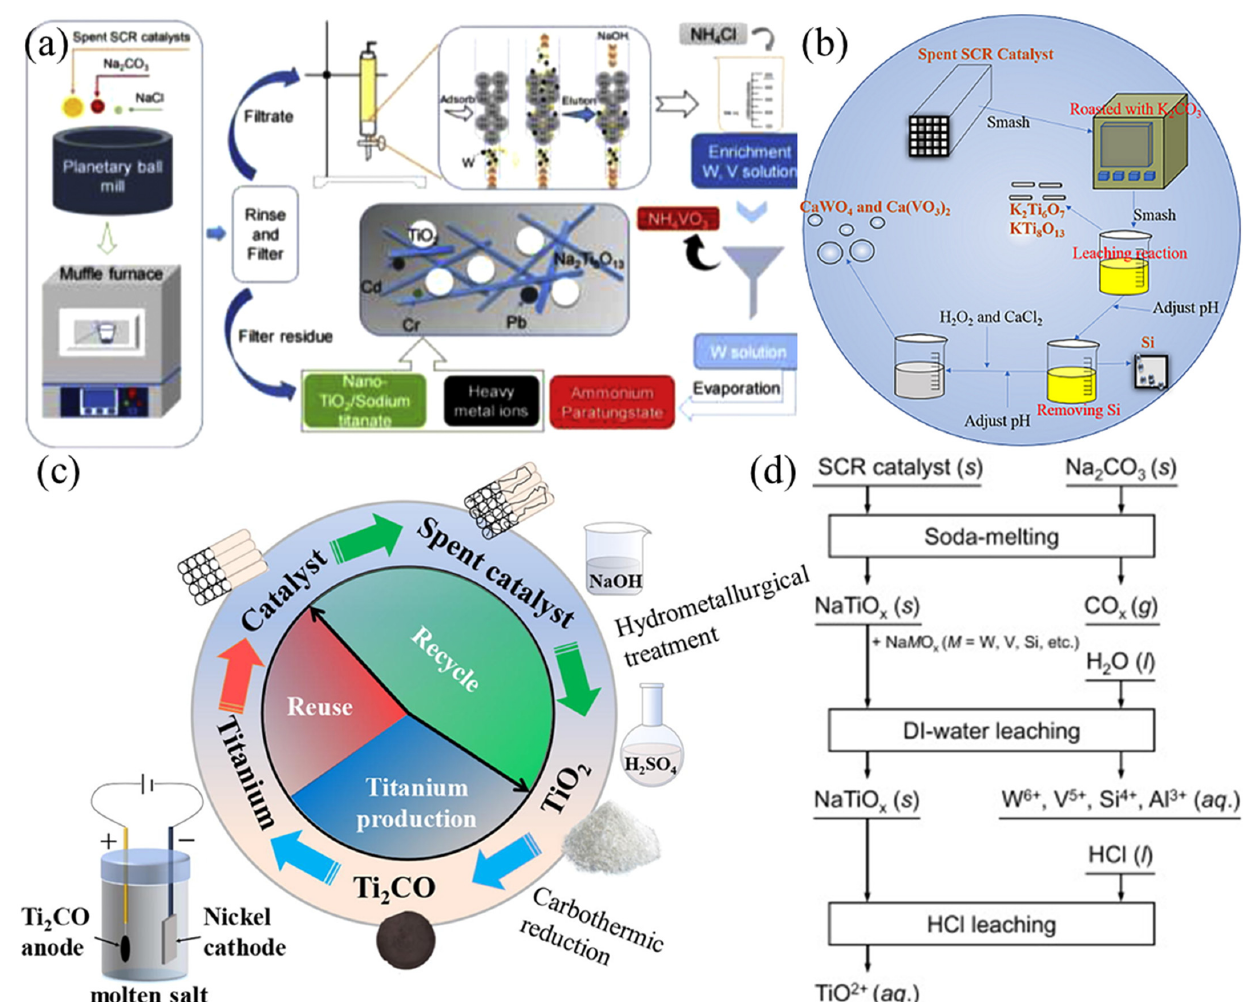
Figure 4. The different recovery products of Ti: ( a ) mixture of rutile TiO 2 , anatase TiO 2 and sodium titanate. Reproduced with permission [49]. Copyright 2020, Elsevier. ( b ) Potassium titanate. Repro- duced with permission [54]. Copyright 2020, Springer Nature. ( c ) Ti metal [6]. Reproduced